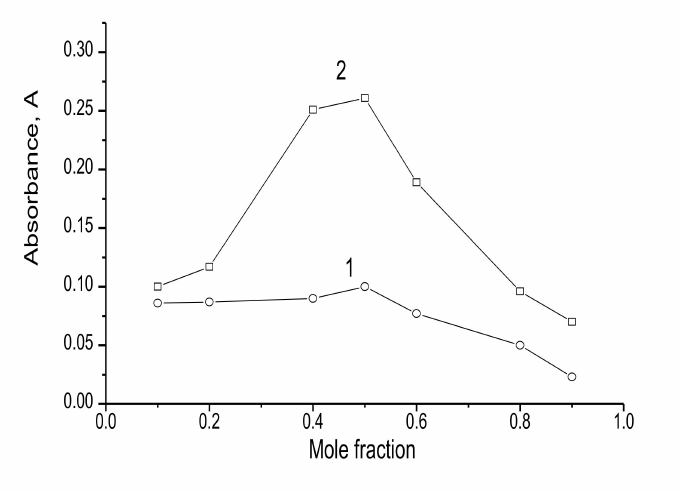
Figure 3. Molar ratio method (Job’s method) using (1 × 10 − 3 M) for (1) Q-DDQ and (2) Q-TCNQ method) using (1 × 10 − 3 M) for (1) Q-DDQ and (2)